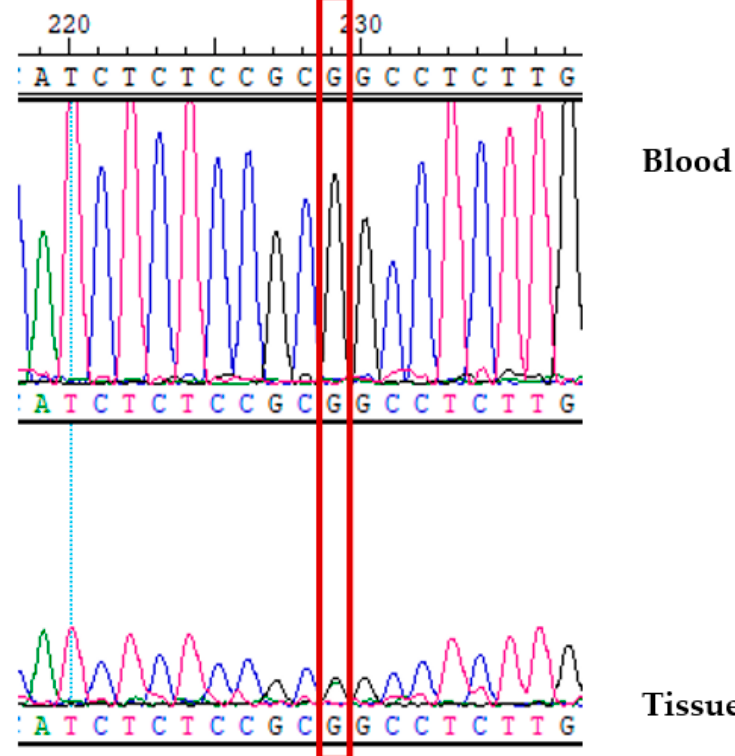
Figure 4. Validation analysis of the candidate variant. Sequence of SIRT in the affected patient’s blood and tissue. Here blue color indicates “C” allele, black—“G”, green—“A” and pink is for “T” allele.